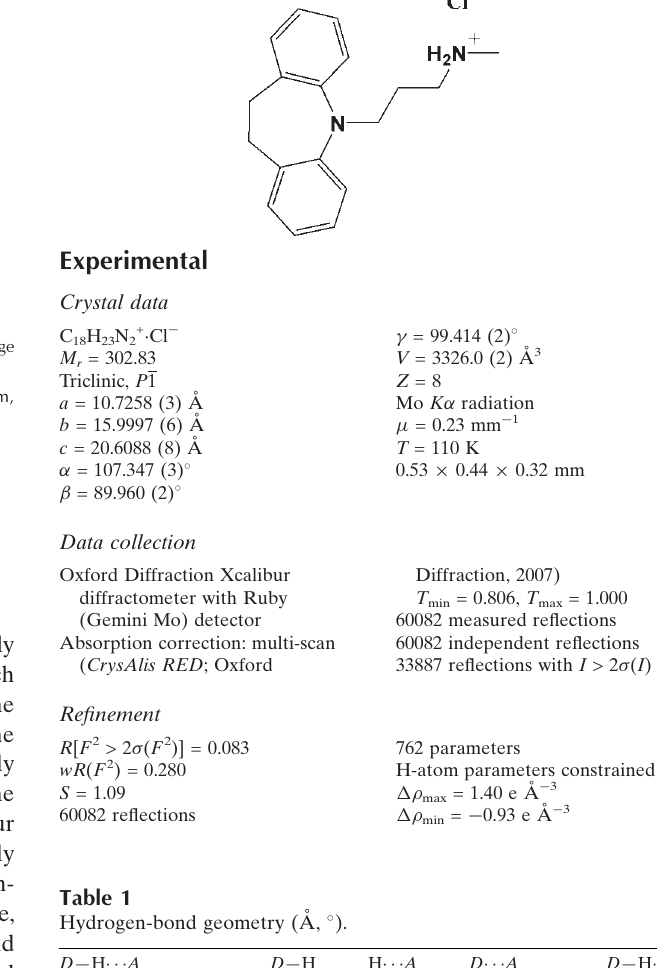
Hydrogen-bond geometry (A˚ , (cid:4)